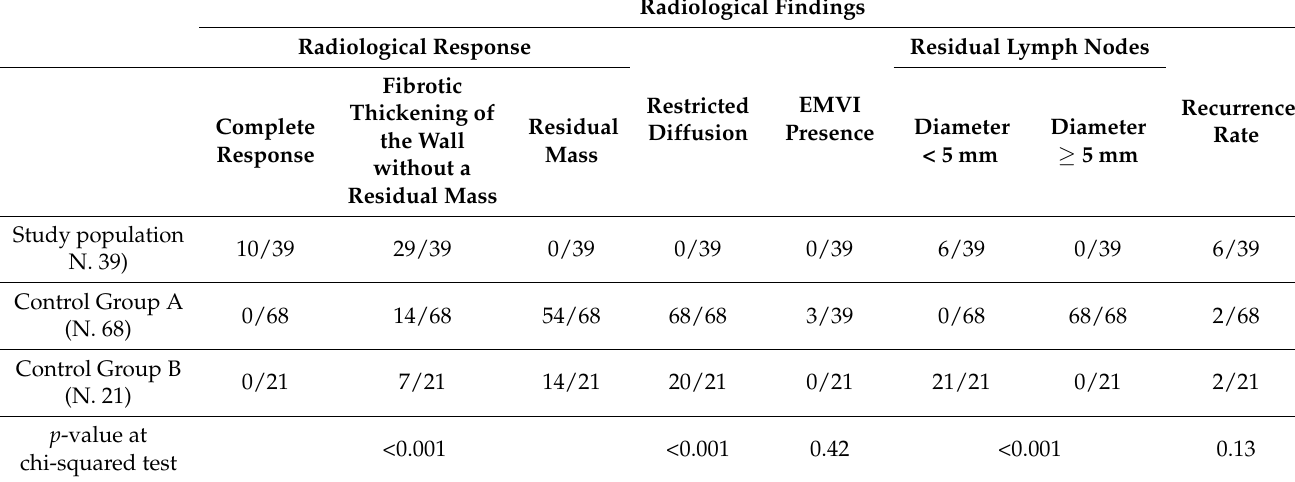
Table 3. Radiological findings in the three patient groups (Study population, Control Group A, Control Group B). Radiological